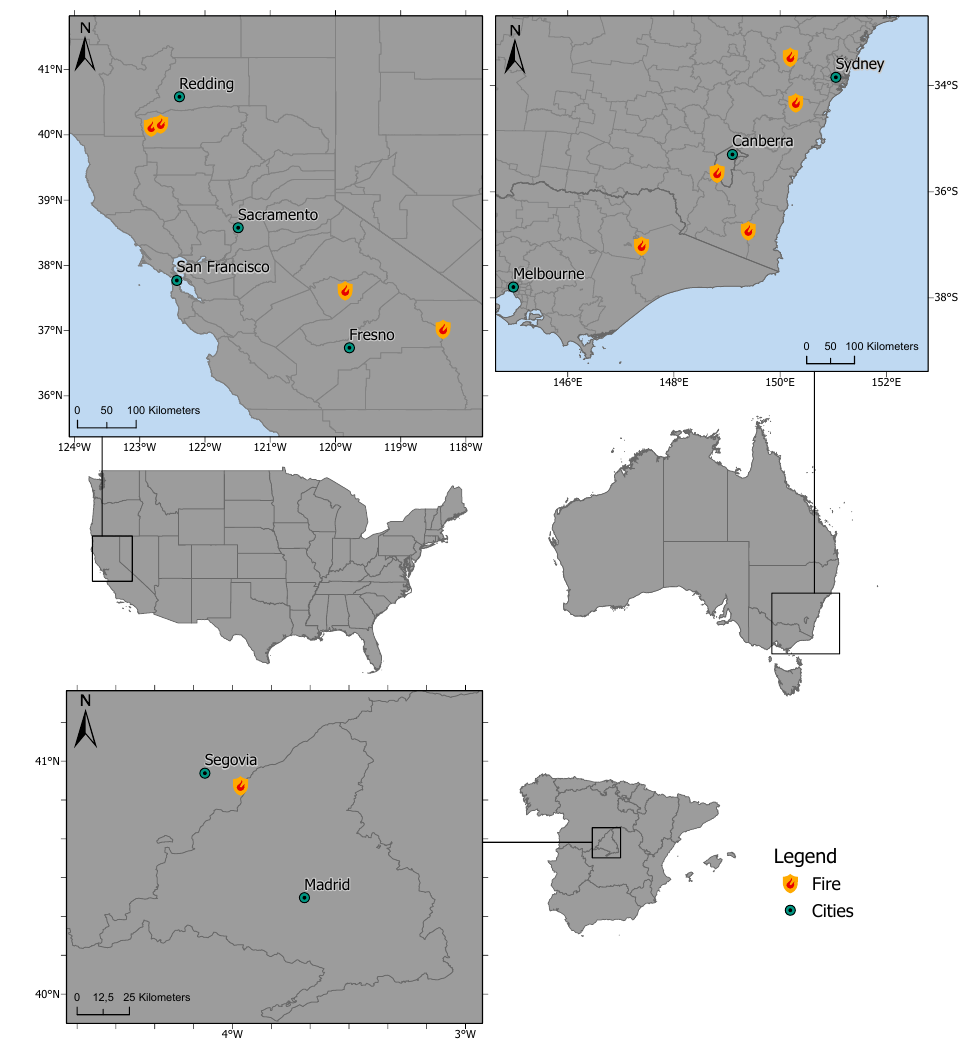
Figure 2. Visualization of the selected areas in the USA ( top left ) and Australia ( top right ) used for the training, validation, and testing of the ML approaches and the areas used as the unknown test dataset in central Spain ( bottom left ). Data basis: © 2018 GADM. Projection: